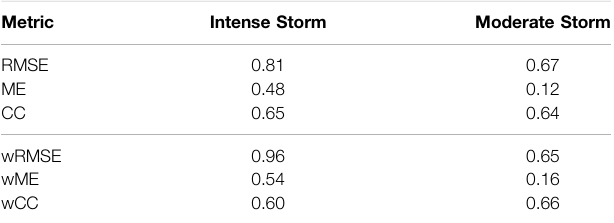
TABLE 1 | Metrics computed for the comparison of log10 ( fl ux) of VERB results and RBSP-B observations for both events. For details, see Section 2.2 . Metric Intense